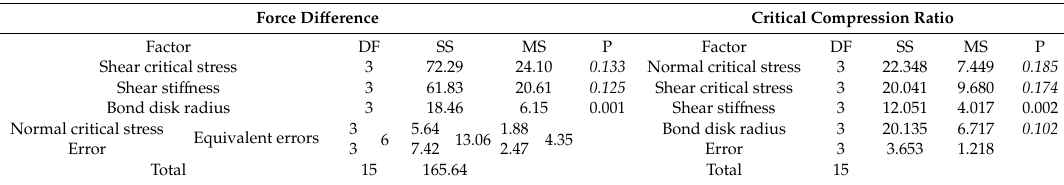
Table 3. ANOVA results of the two responses: DF is the number of free degrees, SS the sum of standard squares, MS the mean square, and is F the f -value calculated with respective variances.